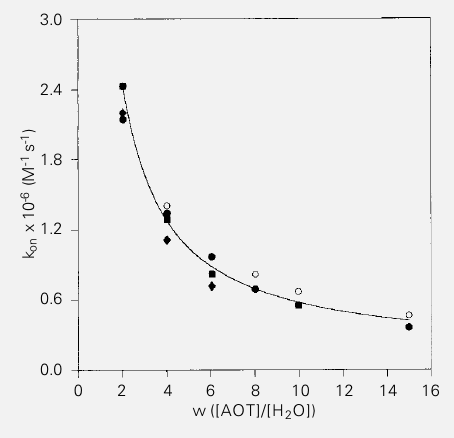
Figure 5 - Proton association rate constants (k on ) of PO - in AOT reversed micelles at various wa- ter and urea/water concentra- tions (w). [AOT] = 0.1 M and [urea] = 0 M ( ! ), 3 M ( • ), 5 M ( (cid:224) ), 10 M ( ¢ ).